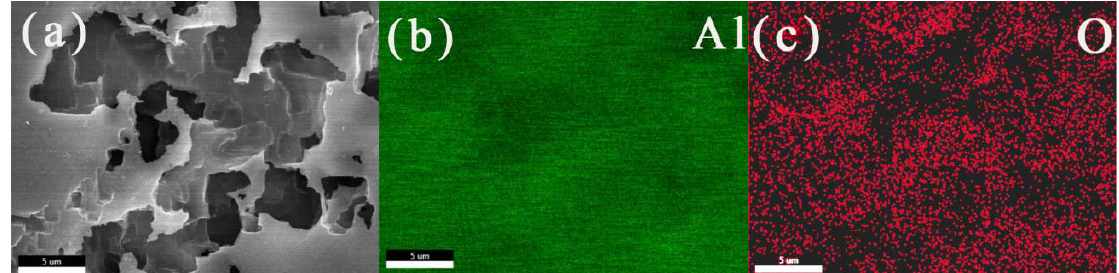
Figure 5. SEM images ( a ) and the Al ( b ) and O ( c ) EDS elemental analyses for the corrosion products on the aluminum electrode surface after a constant voltage corrosion of 0.5 V for 0.5 h in 50 °C deionized water.